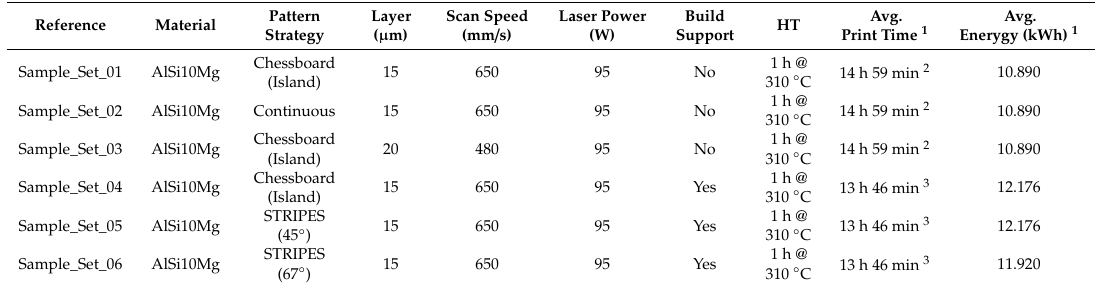
Table 2. Selected AM Process Parameters.